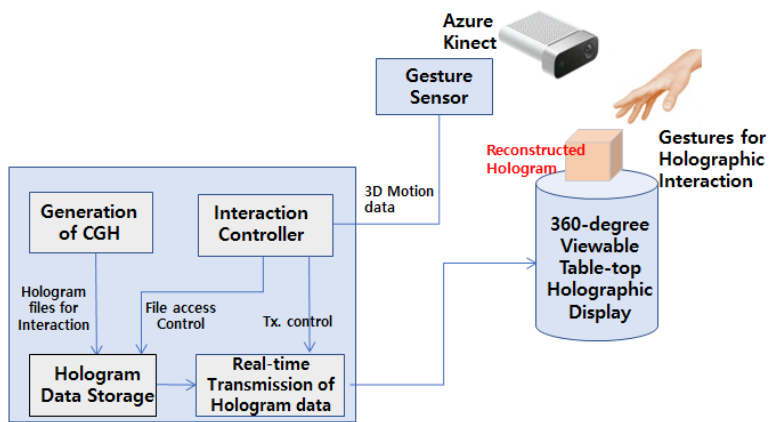
Figure 4. Block diagram of real-time interactive holographic display by hand